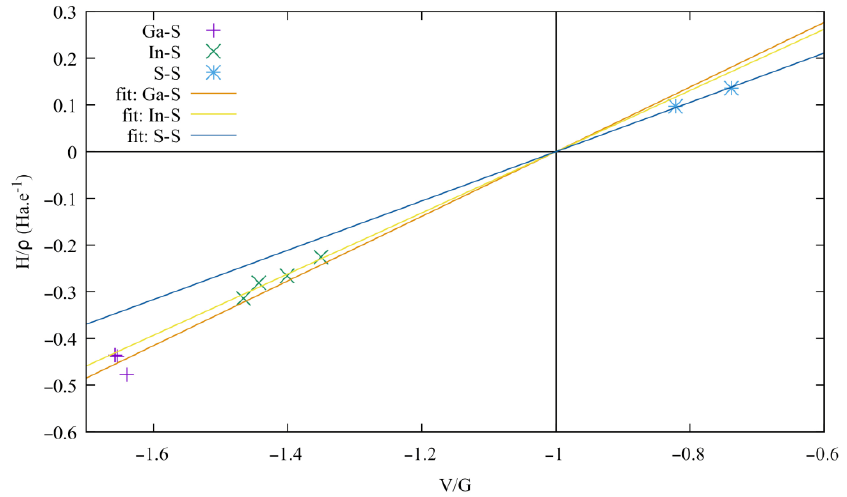
Figure 15. Bond degree versus V/G ratio at the bond critical point of Ga-S, In-S, and S-S bonding. Overall, the topological analysis shows that the bonding interaction between the lay- ers is weak and involves sulfur atoms through a closed-shell interaction. Hence, upon the intercalation of organic molecules, the layers can be easily separated from each other to accommodate the molecules.